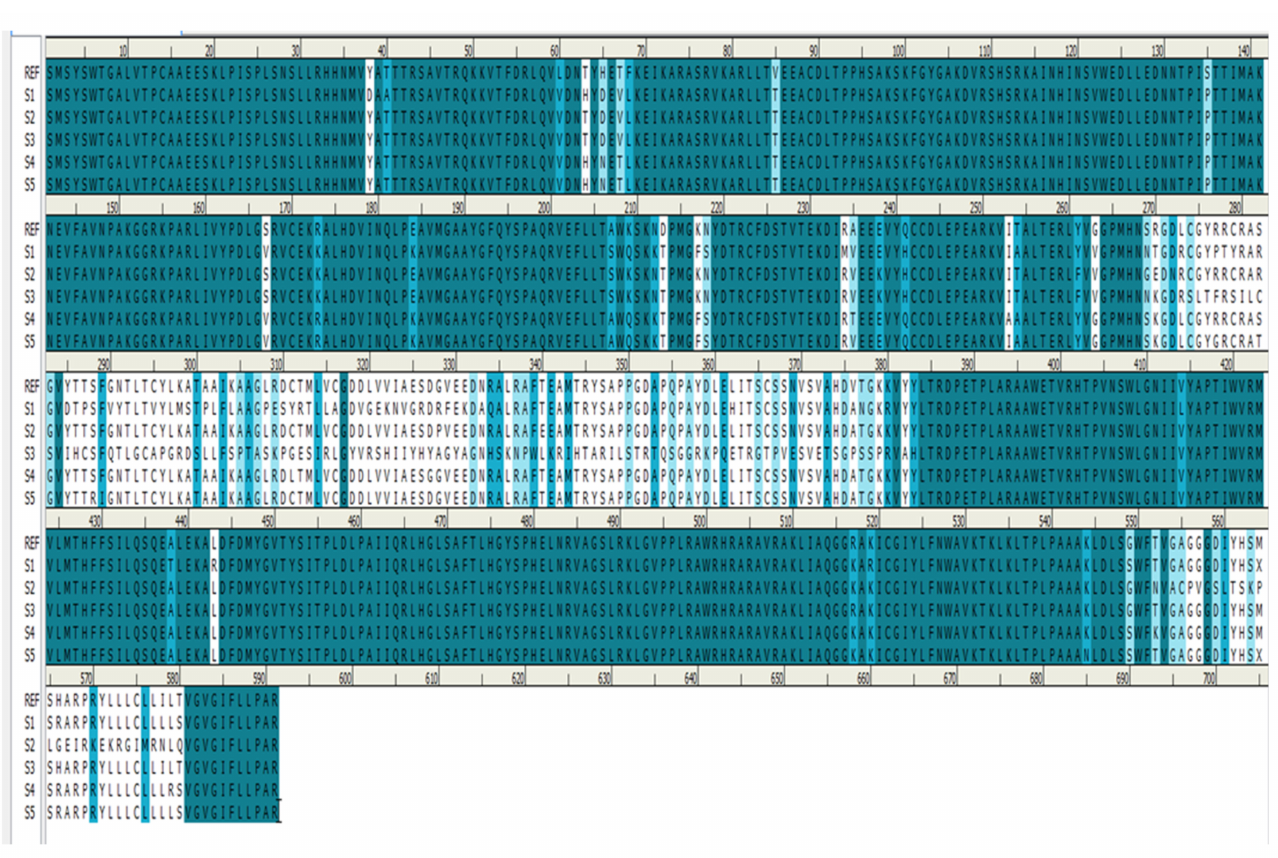
Figure 2. Sequence alignment between the reference (R) (Y11604) and the five resistant samples (S1–S5).